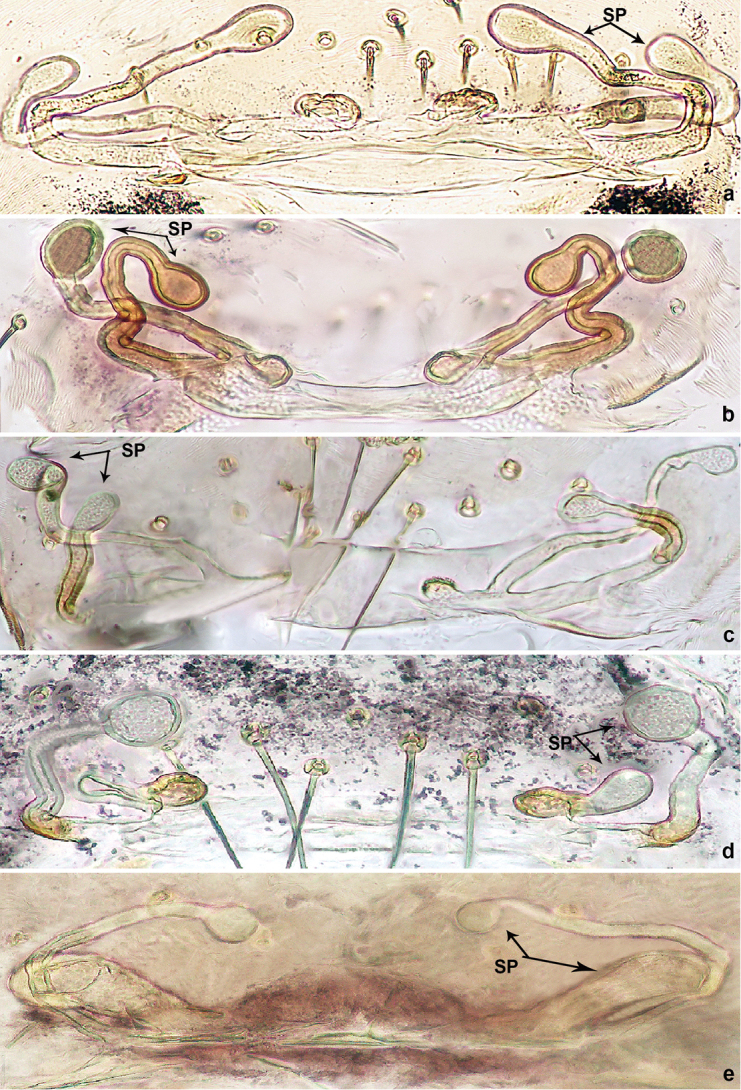
Female internal genitalia of five different species of Luzonacera: aL.changbL.duancL.francescoballarini sp. n. dL.lattuensis sp. n. and eL.peterjaegeri sp. n. Abbreviation: SP = spermathecae.